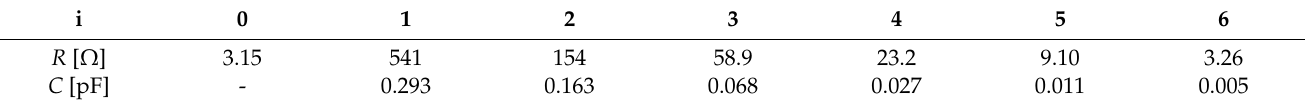
Table 1. Parameters for the equivalent circuit.